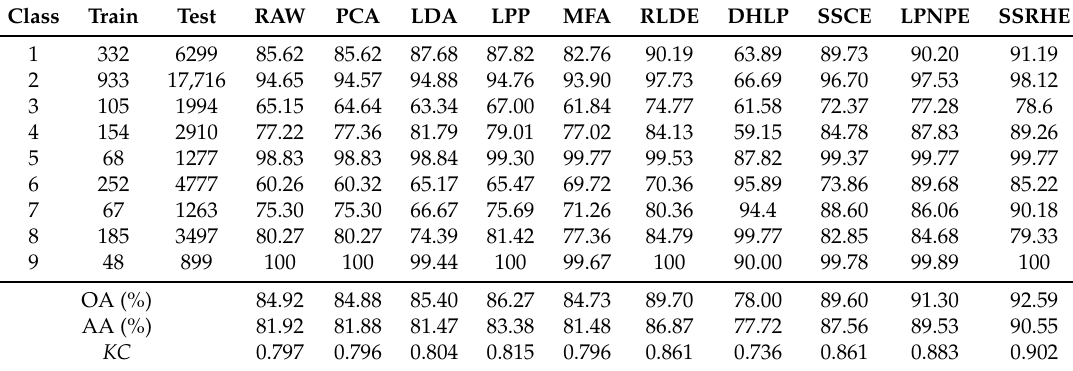
Table 4. Classification results of different classifiers on the PaviaU dataset.